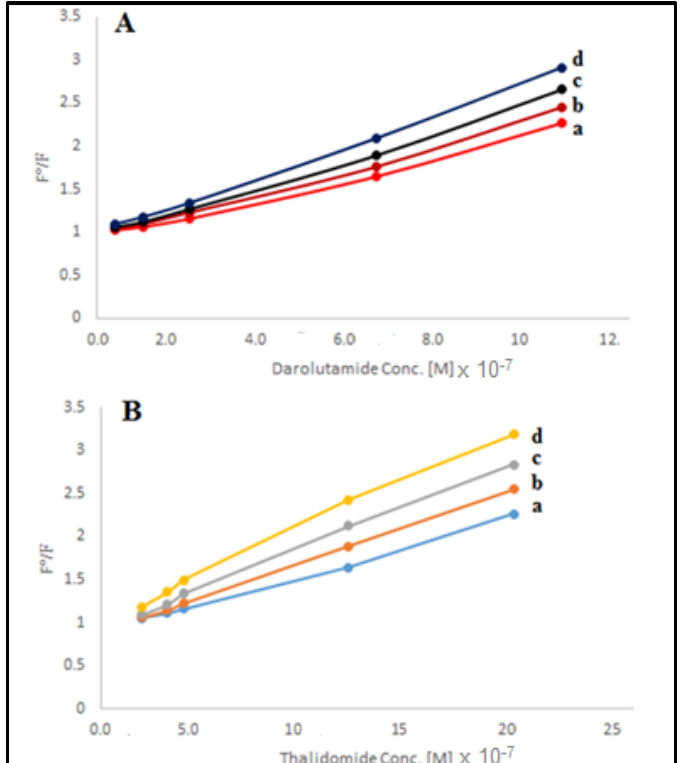
Figure 3. Stern–Volmer plot for interaction of ( A ) darolutamide and ( B ) thalidomide with pyridopyrazolopyrimidine 2 at different temperatures (a) 25 °C, (b) 30 °C, (c) 35 °C, (d) 40 °C.